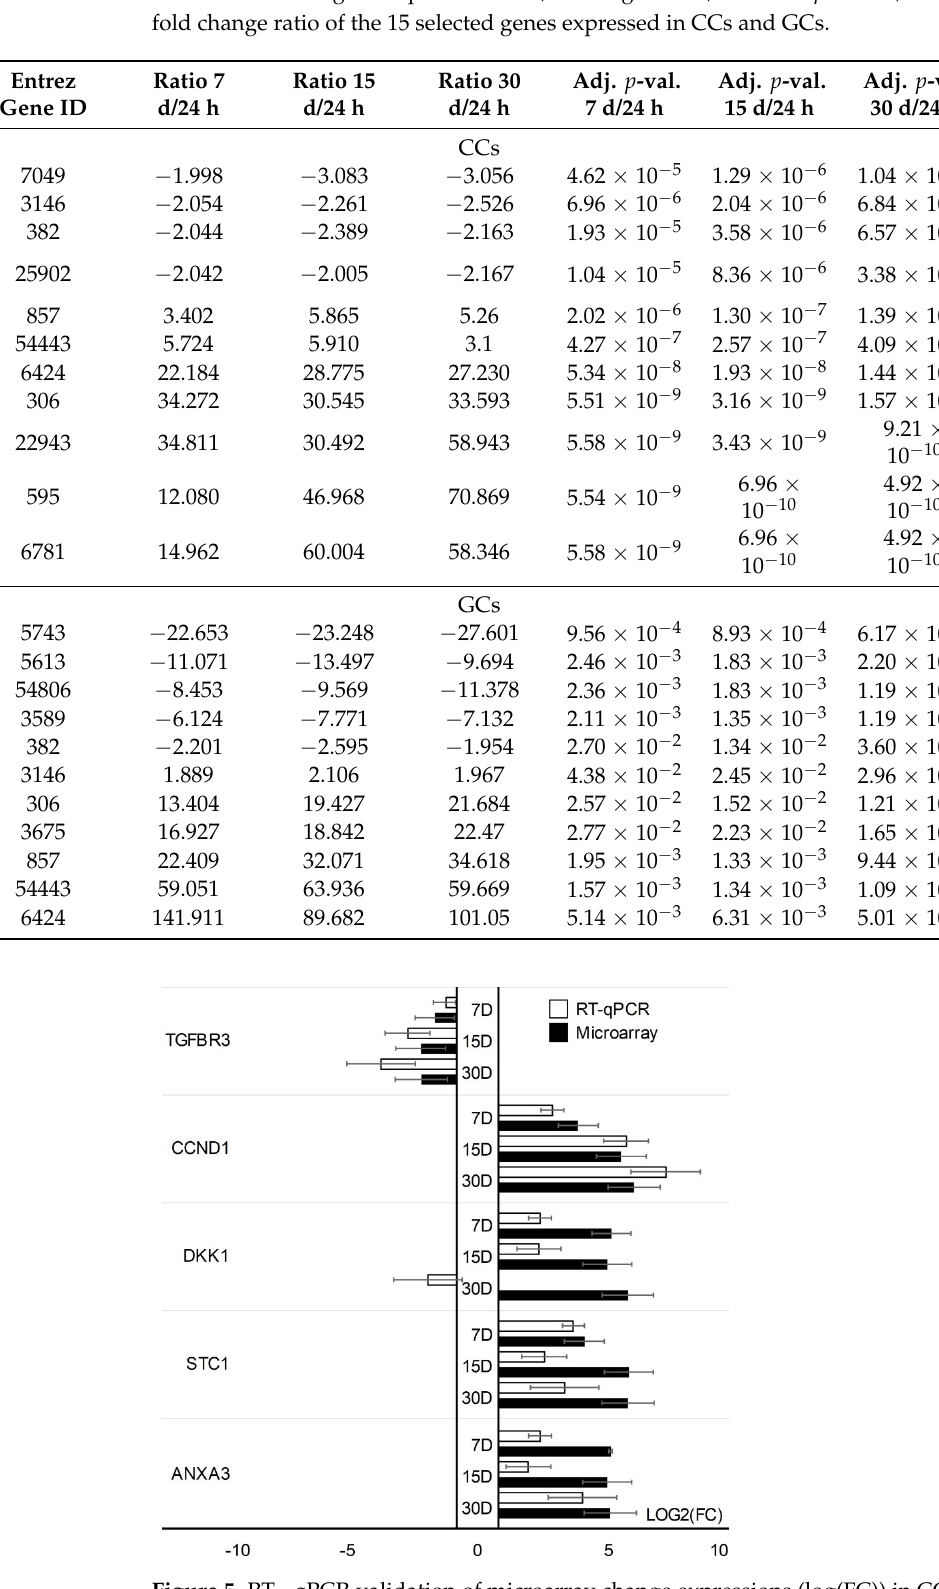
Figure 6. RT − qPCR evaluation of selected genes based upon the microarray data (log(FC)) in GCs. Validation of the microarray method was performed in three separate biological repetitions. Each of the biological repetitions was performed in three technical repetitions; D: day of culture; FC: fold change. The shape of the GCs and CCs was documented at particular time intervals. CC cells very quickly adhered to the bottom of the culture plate, and their shape was spherical a few hours after seeding (Figure 7). The shape of GC cells changed from star-like cells to